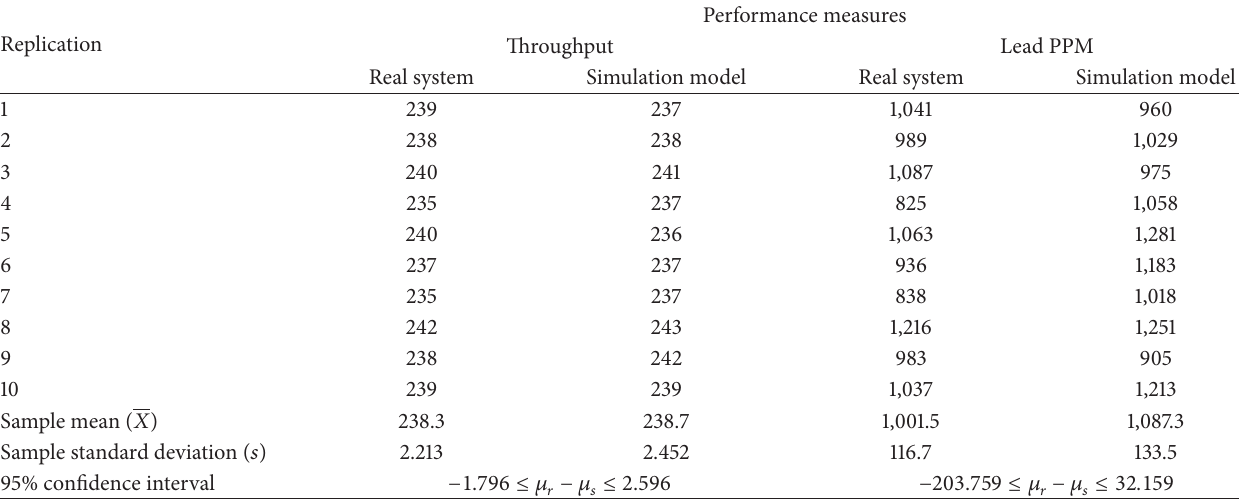
Table 7: Comparison of real system data and simulation results.